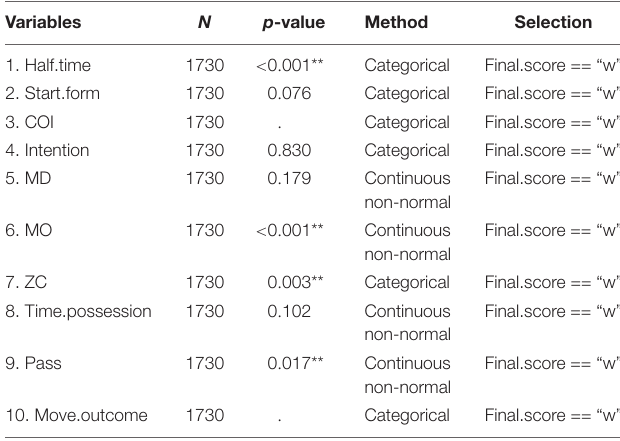
TABLE 4 | Summary of results by groups of ‘ Match.status .’